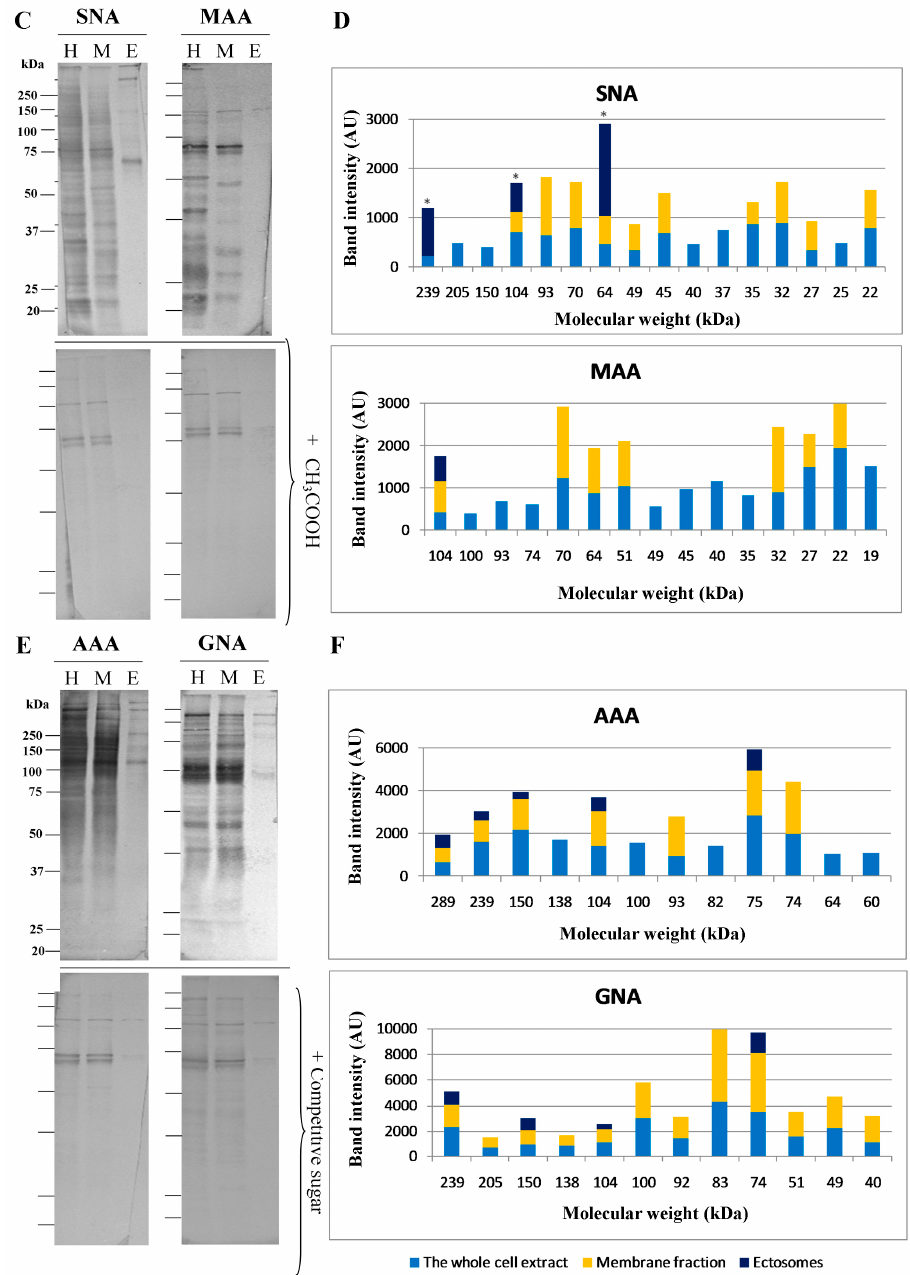
Figure 5. Comparative analysis of lectin-specific glycosignatures in Mel202-derived ectosomes. Reactions with biotinylated ( A ) PHA-L and PHA-E, ( C ) SNA and MAA, and ( E ) AAA and GNA, where lectins are shown in the upper panels and controls with blocking solution of competitive sugars or CH 3 COOH (as indicated in Supplementary Data 1) are shown in the lower panels. Seventy micrograms of protein were loaded per lane. Detection was performed via nitro-blue tetrazolium and 5-bromo-4-chloro-3'- indolyphosphate (NBT/BCIP) staining. H – the whole cell extract, M – membrane fraction, E – ectosomes. Densitometric analysis of ( B ) PHA-L- and PHA-E-, ( D ) SNA- and MAA-, and ( F ) AAA- and GNA-positive bands. The intensity of detected bands was expressed in arbitrary units (AU) as a peak area on a respective densitogram. Each bar represents the intensity of corresponding bands in the whole cell extract, membrane fraction, and ectosomes from Mel202 cells. * denotes bands that were enriched in ectosomes, relative to the membrane fraction. The values from control lectin blots with blocking solutions were subtracted beforehand.